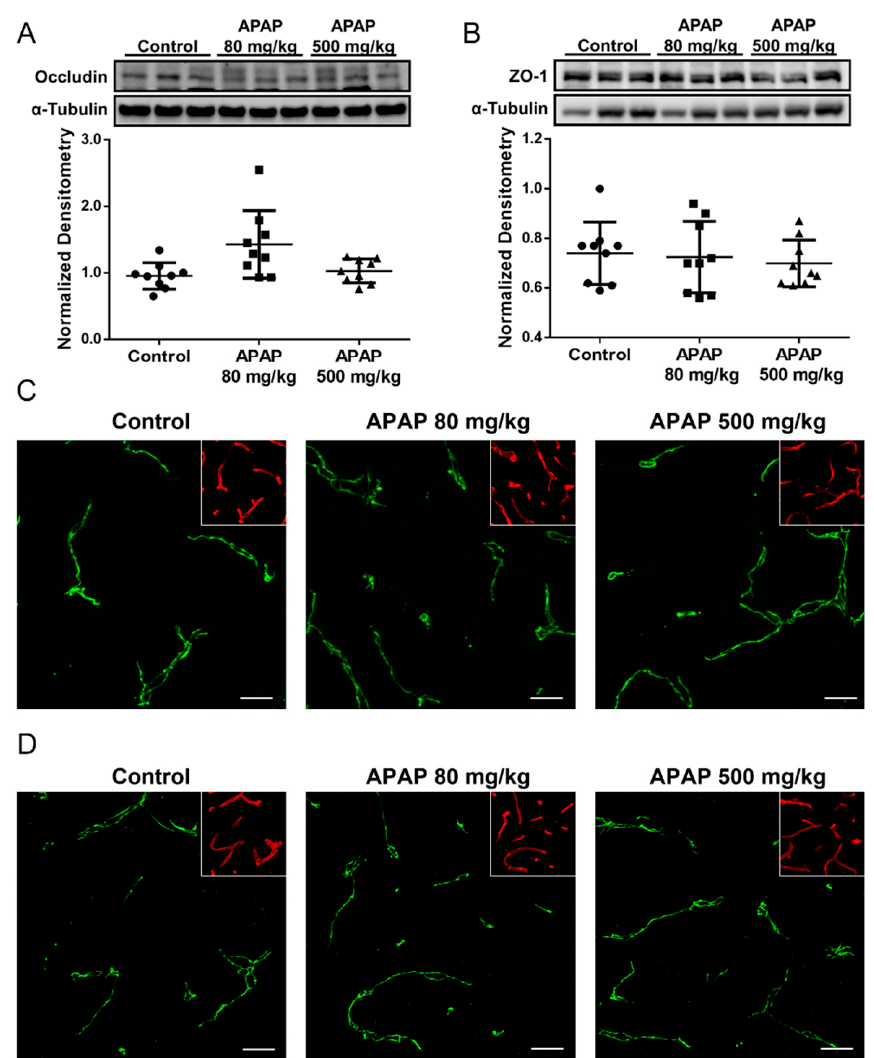
Figure 3. Occludin and ZO-1 levels remain unchanged three hours following APAP treatment. ( A ) Western blot ( top ) and densitometric analysis ( bottom ) shows comparable occludin levels in isolated brain microvessel of APAP (500 mg/mL)-treated and control rats ( n = 9). Densitometric data are expressed as mean ± S.D. ( B ) Western blot ( top ) and densitometric analysis ( bottom ) shows comparable ZO-1 levels in isolated brain microvessel of APAP (500 mg/mL)-treated and control rats ( n = 9). Densitometric data are expressed as mean ± S.D. ( C ) Confocal microscopy shows similar overall occludin expression in cortical microvessel of rats treated with APAP (80 or 500 mg/kg) as vehicle. Microvessels were stained with lectin (red) and are shown in the inset to demonstrate vascular localization of occludin. Scale bar = 20 µ m. ( D ) Confocal microscopy shows similar overall ZO-1 expression in cortical microvessel of rats treated with APAP (80 or 500 mg/kg) as vehicle. Microvessels were stained with lectin (red) and are shown in the inset to demonstrate vascular localization of ZO-1. Scale bar = 20 µ